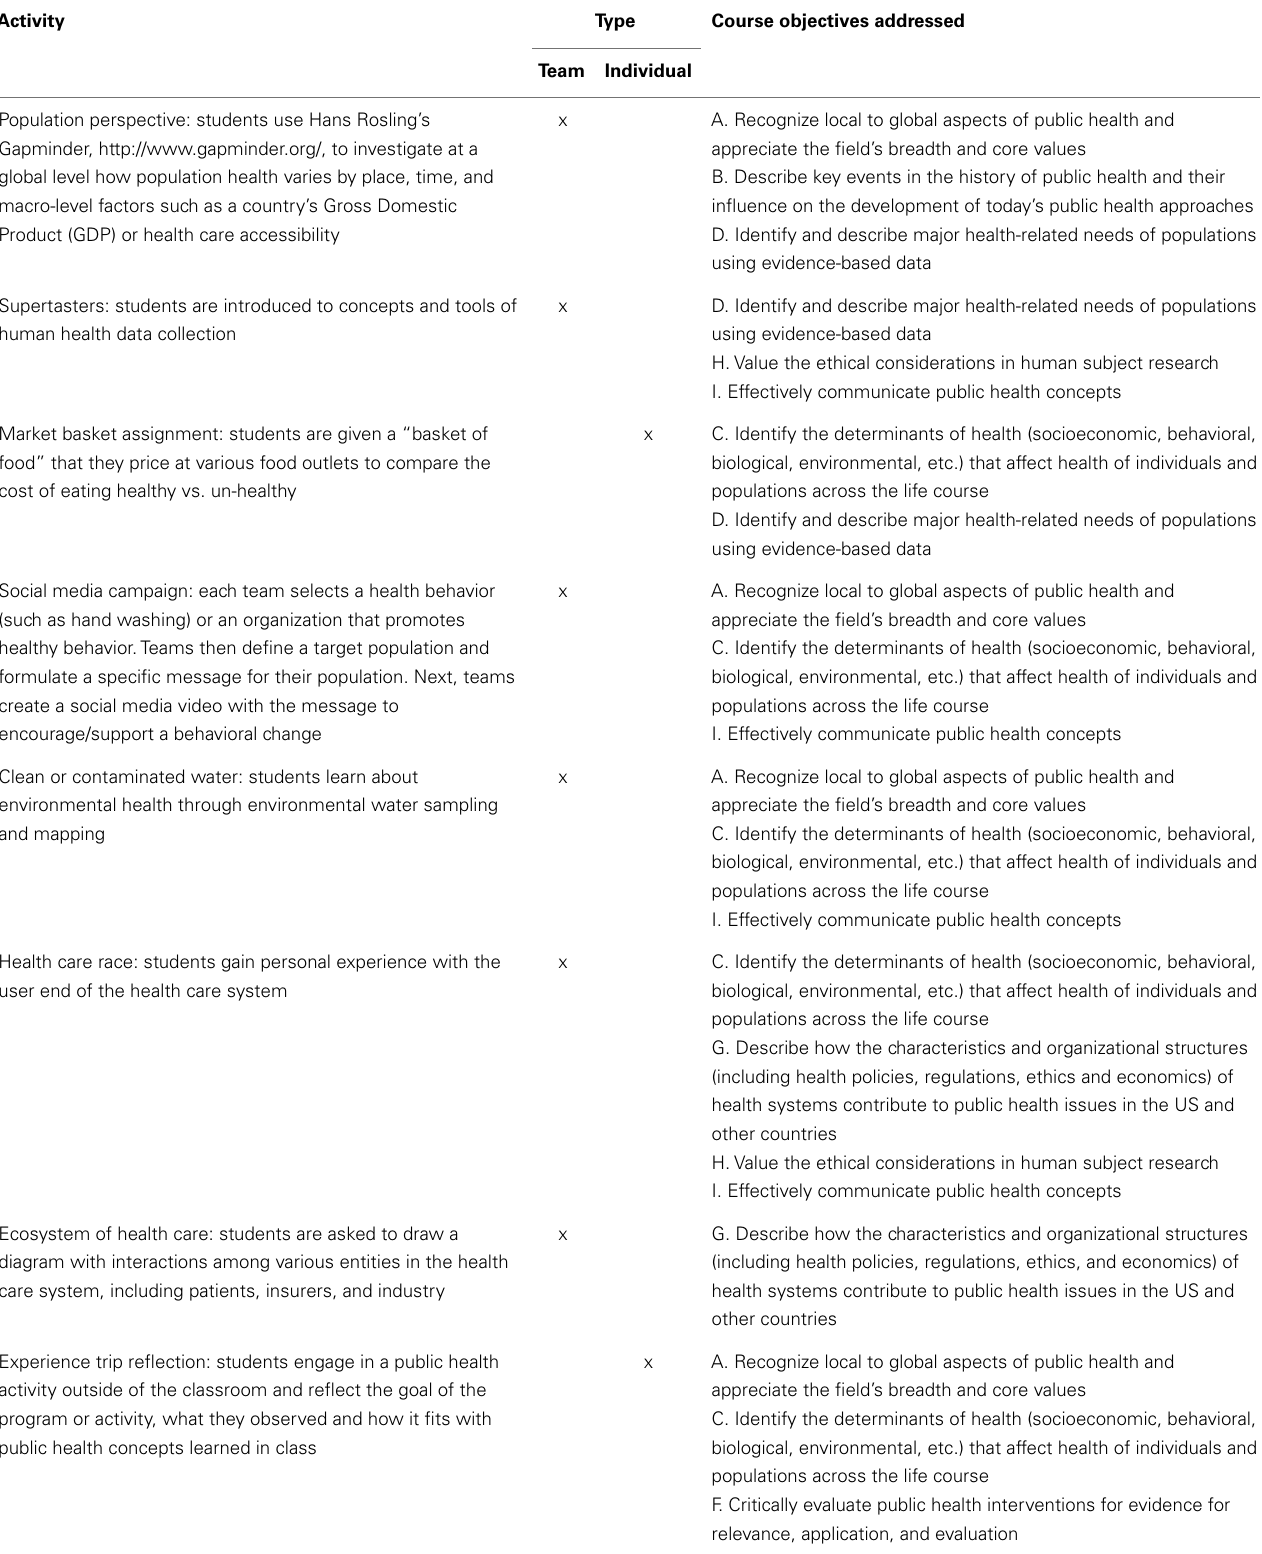
Table 2 | Class assignment alignment with course objectives